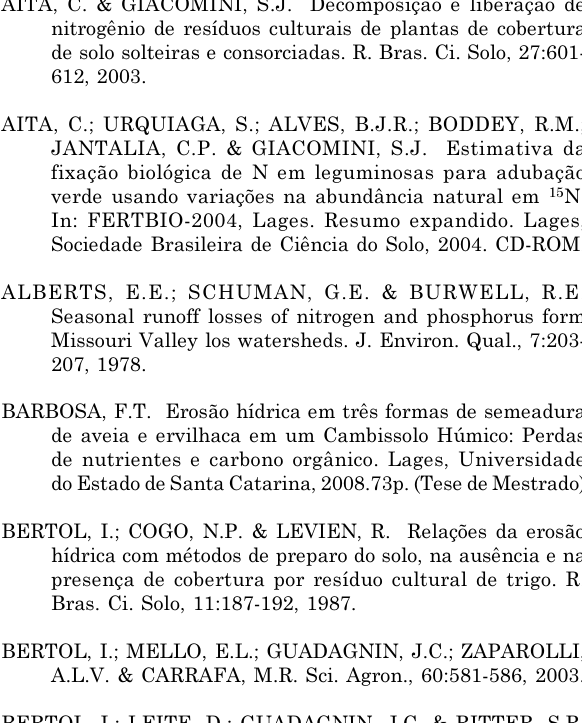
Figura 3. Relação entre o teor de N na água de enxurrada e o teor de N na camada de 0-2,5 cm do solo, nos tratamentos, nas culturas e nos testes de chuva simulada (média das